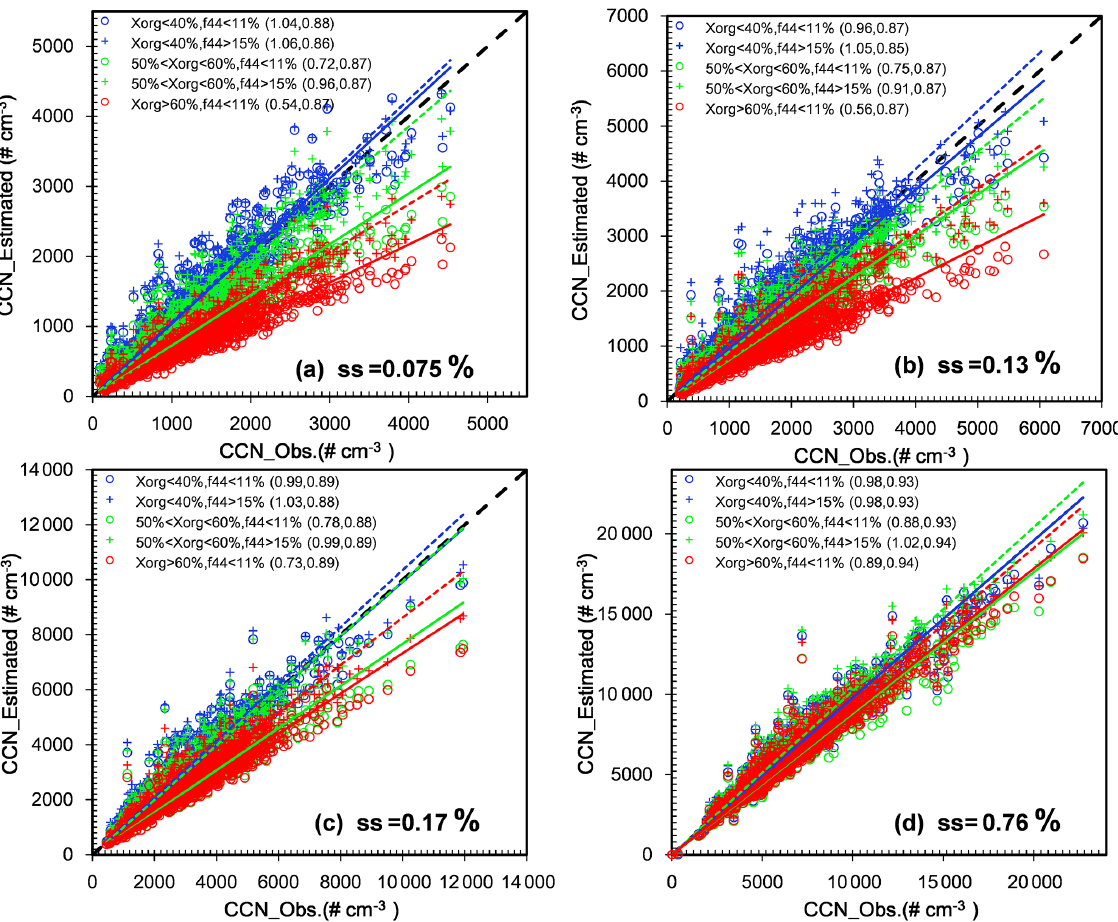
Figure 5. The sensitivity of N CCN to both organics volume fraction ( x org ) and oxidation level (using f 44 , the fraction of m/z 44 in aerosol organic material) of organics at supersaturation levels of (a) 0.075, (b) 0.13, (c) 0.17, and (d) 0.76% for cases when x org = 35% (blue circles), 52% (green circles), and 66% (red circles). The size-resolved CCN data were sorted when the x org >60%, 50%< x org <60%, and x org <40%, respectively, to do the sensitivity examination. Linear best-fit lines through each group of points are shown. Slopes and R 2 values are given in